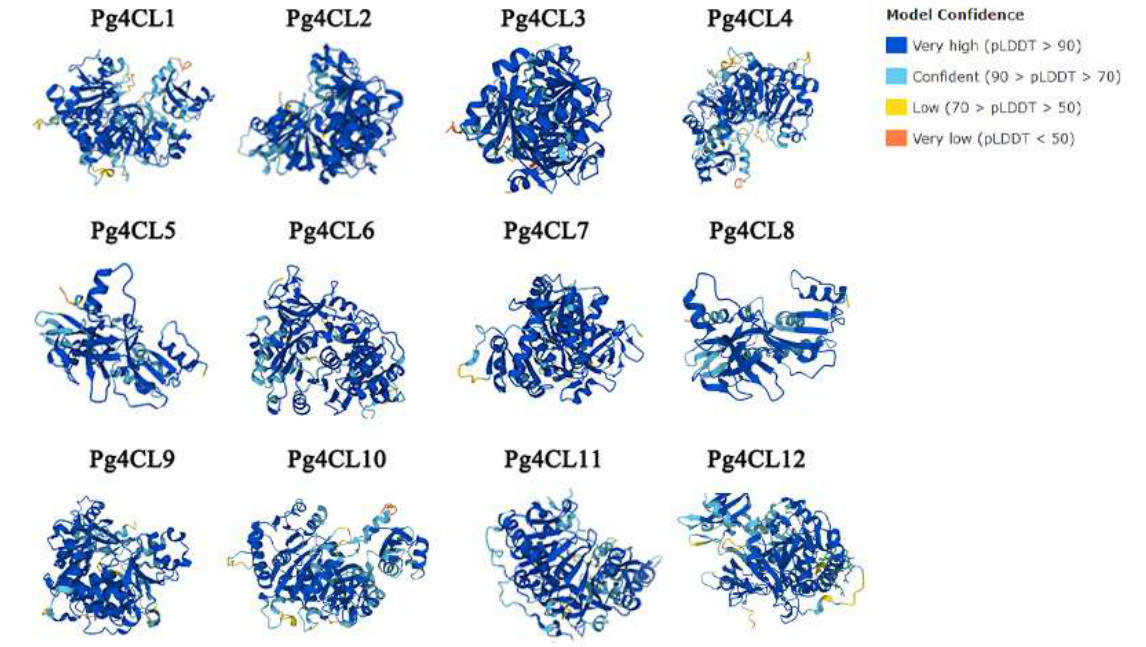
Figure 4. Tertiary structure of Pg4CL proteins. The tertiary structure of the protein was predicted through the AlphaFold. Model confidences are indicated by different colors. Blue, light blue, yellow, and red represent very high, confident, low, and very low confidence,